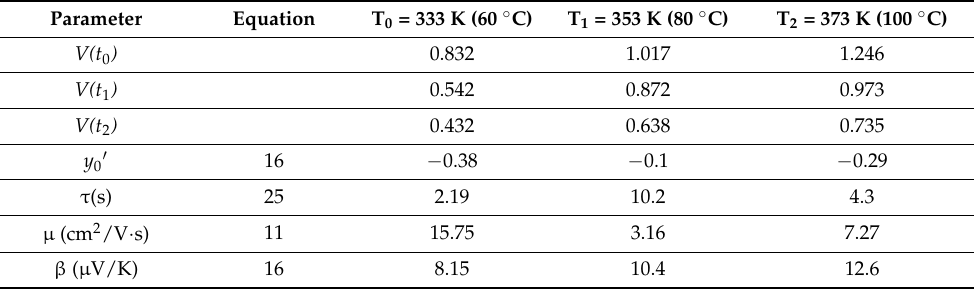
Table 4. Measured voltage and basic calculated parameters of the high-resistance AZO film.